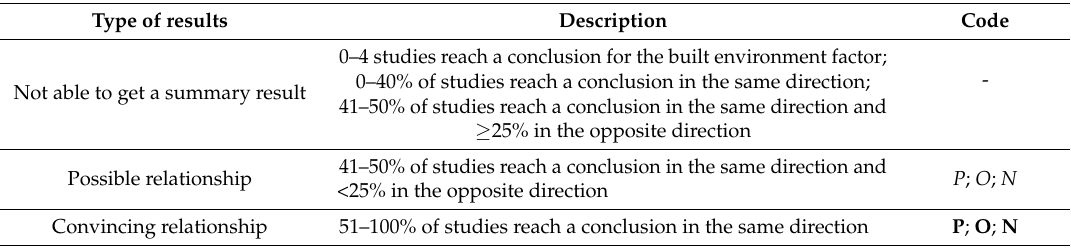
Table 2. Criteria for coding summary